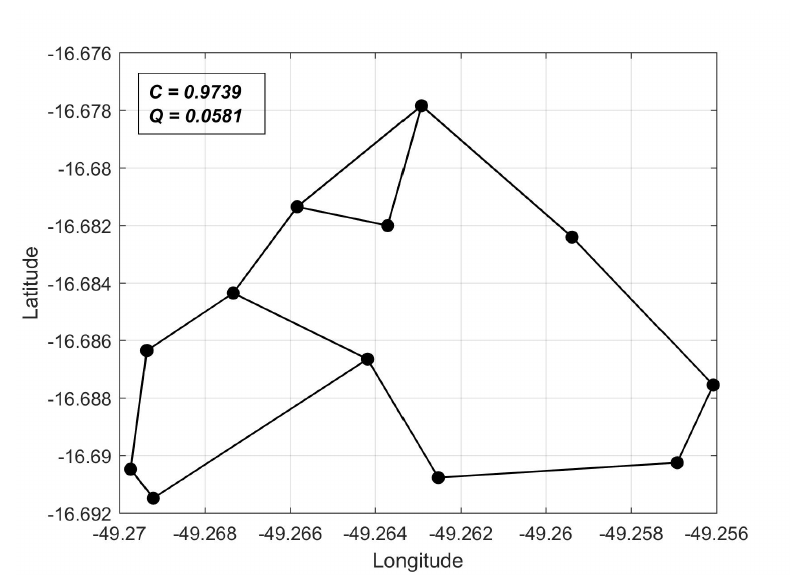
Figure 7. Solution P 2 obtained for r C = 0.5 and r Q = 0.5.